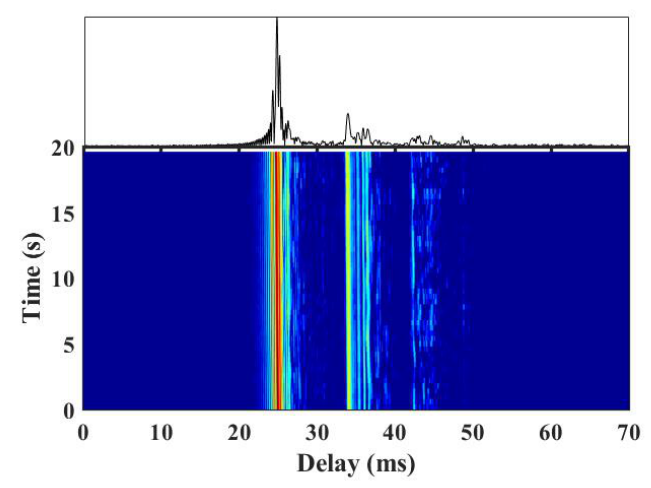
Figure 11. Measured channel in a certain period.